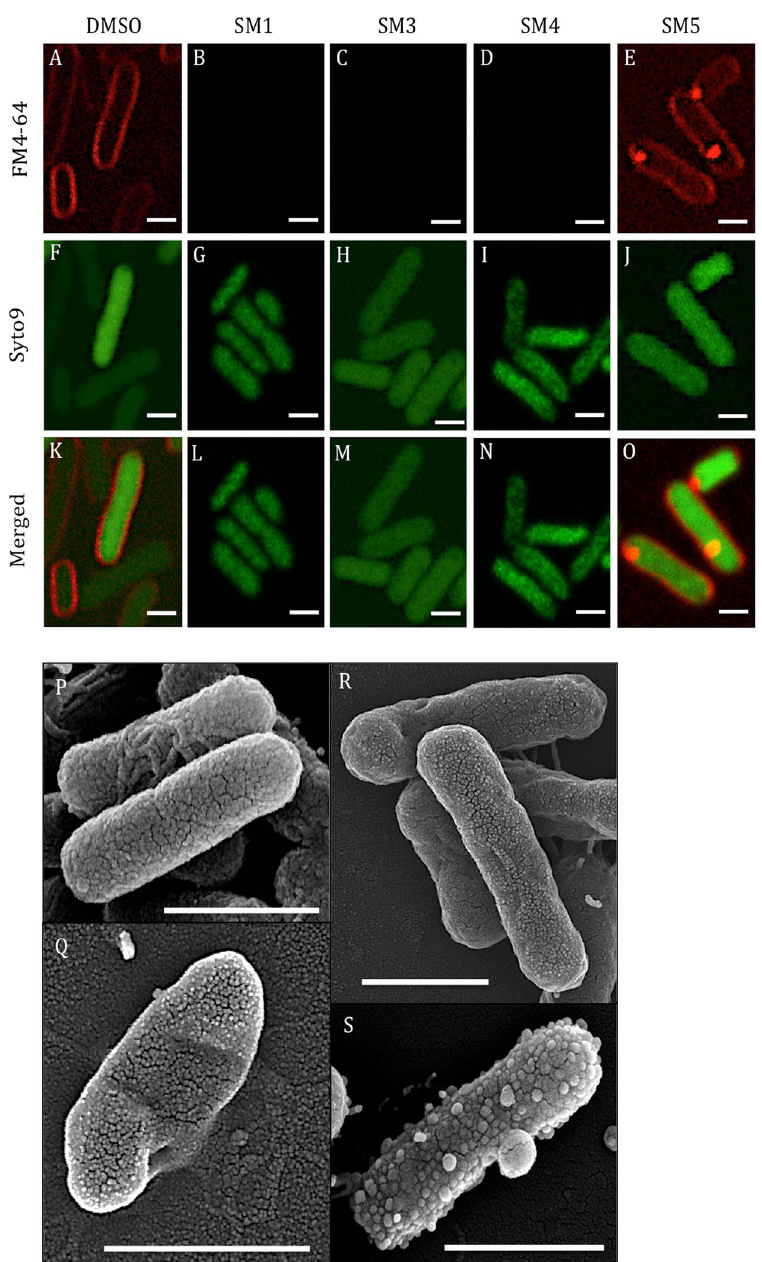
Figure 3. Confocal and scanning electron microscopy (SEM) analyses of Salmonella enterica subsp. enterica serotype Typhimurium after challenge with five times the minimal bactericidal concentraiton of small molecules (5X MBC of SMs) for 3 hrs. ( A – O ) Confocal microscopy: ( A – E ) S . Typhimurium cell membrane stained with FM4-64; ( F – J ) S . Typhimurium nucleic acids stained with SYTO9; ( K – O ) Merged pictures of the FM4-64 and SYTO9 staining. ( P – S ) SEM: ( P ) 1% dimethyl sulfoxide (DMSO) treated Salmonella ; ( Q ) SM1 treated Salmonella ; ( R ) SM4 treated Salmonella ; ( S ) SM5 treated Salmonella ; Bar: 1 μ